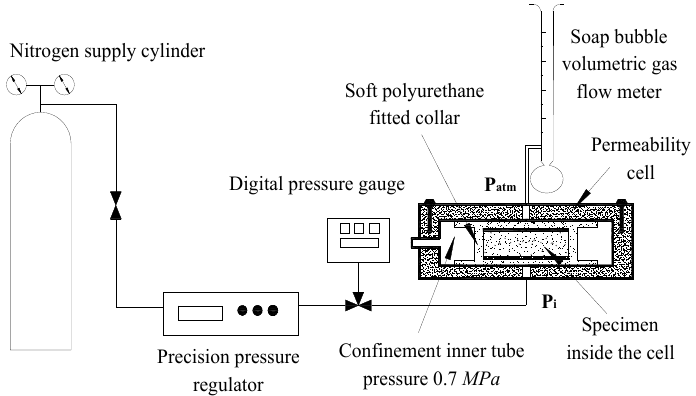
Figure 3. A schematic diagram of the test device for testing the permeability of normal concrete.